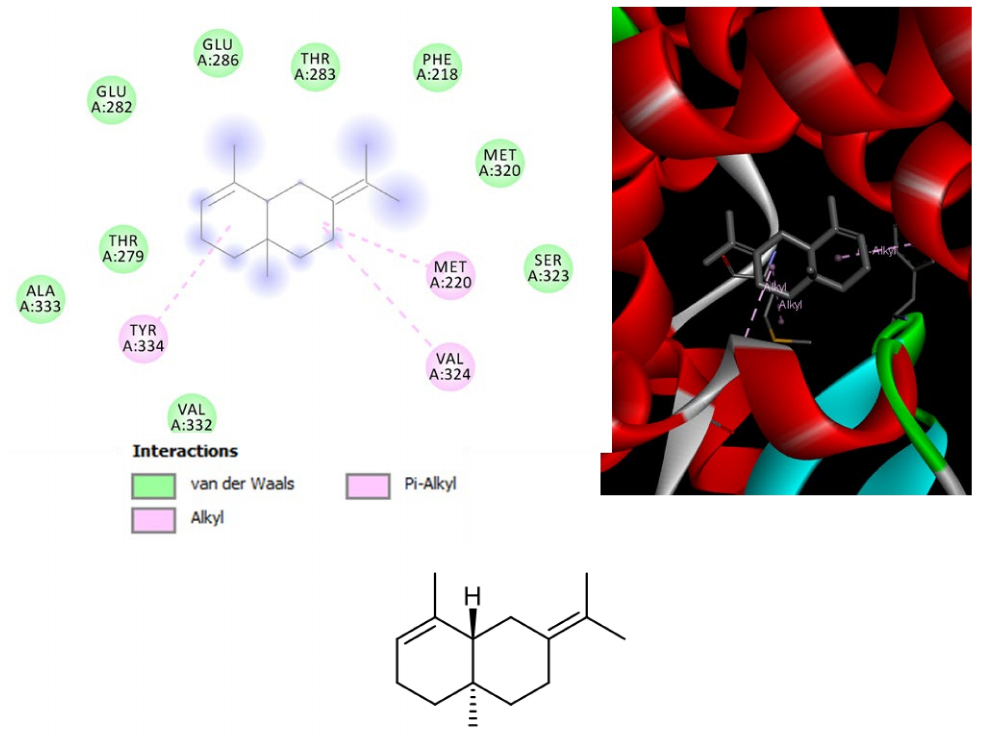
Figure 3. Structure and in silico interactions between selina-3,7(11)-diene and peroxisome proliferator-activated receptor α (PPAR- α ; PDB: 2P54). Free energy of binding ( ∆ G) and affinity (Ki) are − 7.2 kcal/mol and 5.4 µ M,